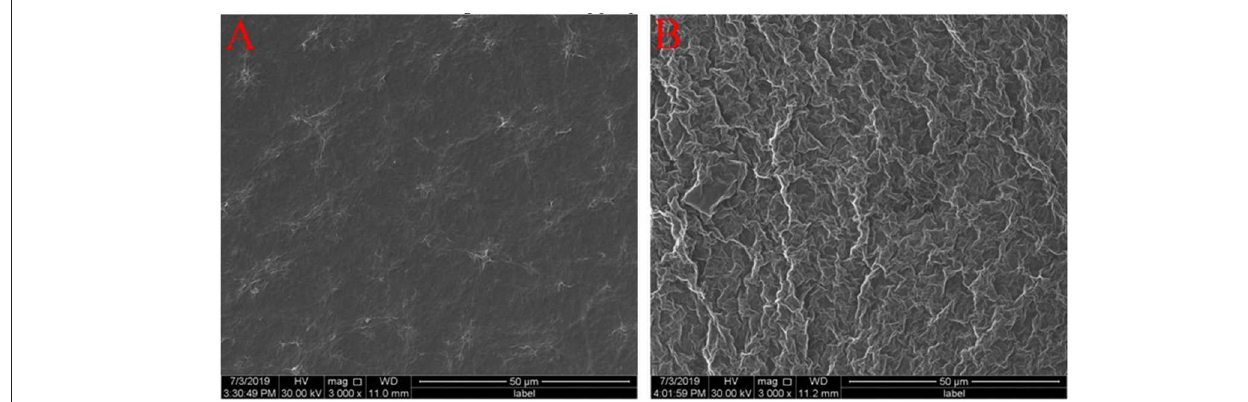
FIGURE 3 | SEM images of ErGO films (A) and ErGO-CP6 films (B) modified GCE.